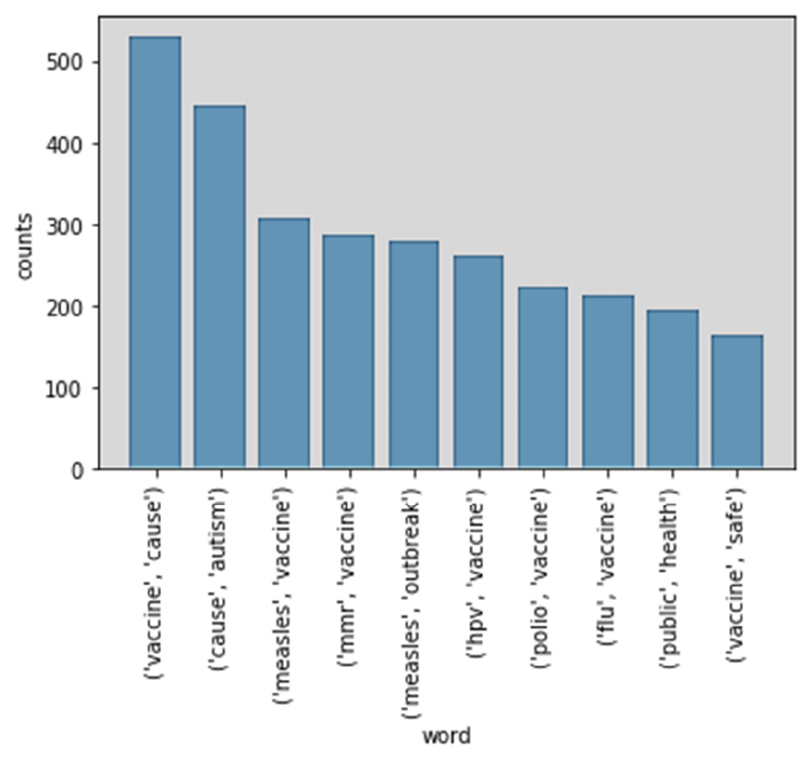
Figure 9. Top 10 bigram phrases.